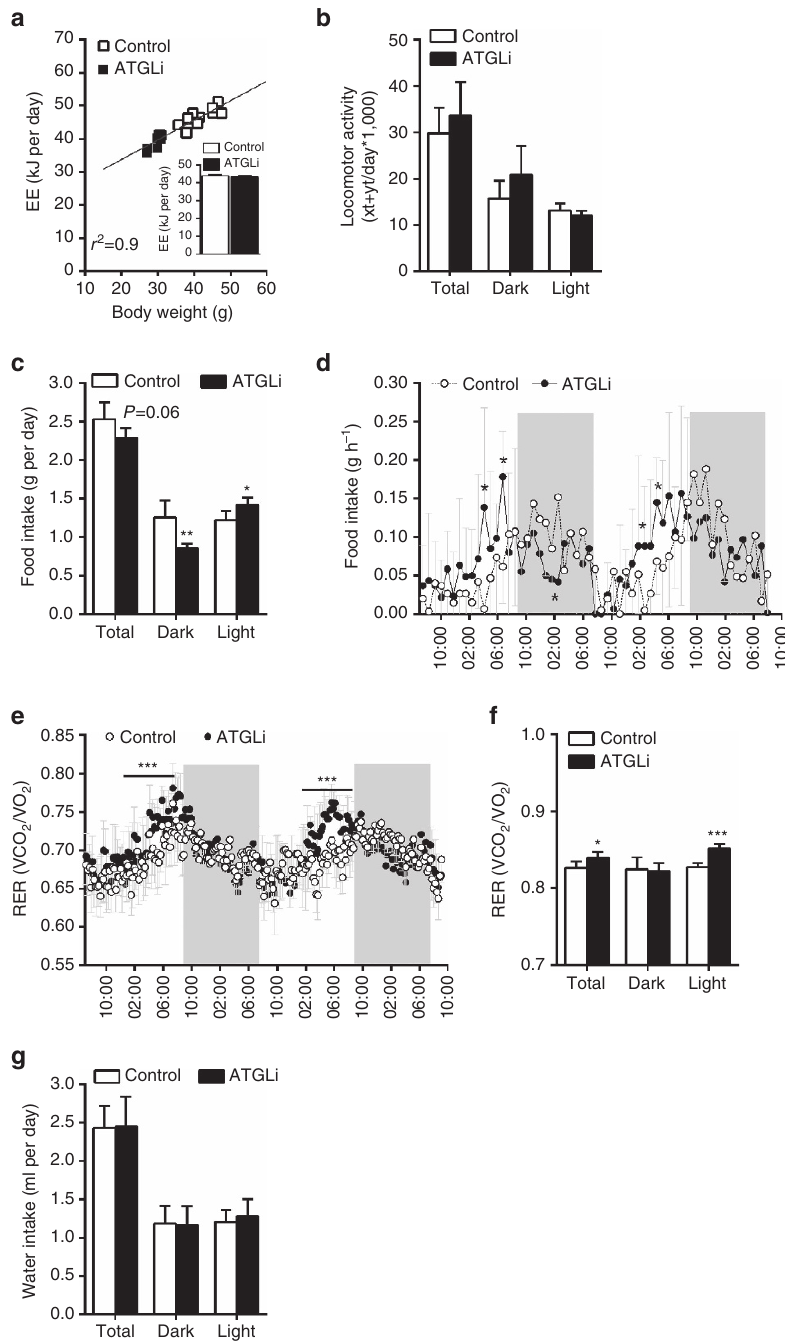
Figure 2 | Metabolic characterization of mice fed a HFD in the presence and absence of Atglistatin. Six weeks old male C57Bl6J mice were fed a HFD (45kJ% fat; 22.1kJg (cid:2) 1 ) for 50 days. Thereafter, mice were fed a HFD in the presence and absence of Atglistatin for 30 days. Metabolic phenotyping was performed using a laboratory animal monitoring system (LabMaster, TSE Systems, n ¼ 6 per group). Mice were familiarized with the metabolic cages for 3 days prior measurement. ( a ) EE was calculated using the formula: EE(kJ per day) ¼ 15,818*VO 2 þ 5,176*VCO 2 /1,000*24 and is plotted against body weight. Linear regression analysis was performed using GraphPad prism software. Data represent single mice. ( a , insert) EE is expressed as adjusted means based on a normalized mouse weight of 35.73g determined using ANCOVA, P ¼ 0.94. ( b ) Locomotor activity per day. ( c ) Food intake per mouse and day, and ( d ) per mouse and hour during the course of the day. ( e ) Respiratory exchange ratio (CO 2 /O 2 ) during the course of the day and ( f ) per day. Mice were kept on a 14h light and 10h dark cycle. Grey bars indicate dark phases. ( g ) Water intake per mouse and day. Data represent mean ± s.d. Statistical significance between control and ATGLi was determined by Student’s two-tailed t -test; * P o 0.05, ** P o 0.01 and *** P o chow-fed ATGLi mice compared with control mice (Suppleme- HFD-fed WT mice, Atgl inhibition improved glucose clearance in ntary Fig. 7c,d). Together, these findings suggest that the inhi- ob/ob mice in GTT (area under the curve: (cid:2) 40%; Fig. 4e) and bition of lipolysis improves glucose homeostasis in both dietary ITT (area under the curve: (cid:2) 40%; Fig. 4f) experiments. and genetic models of IR. In contrast, glucose and insulin tolerance was unchanged in